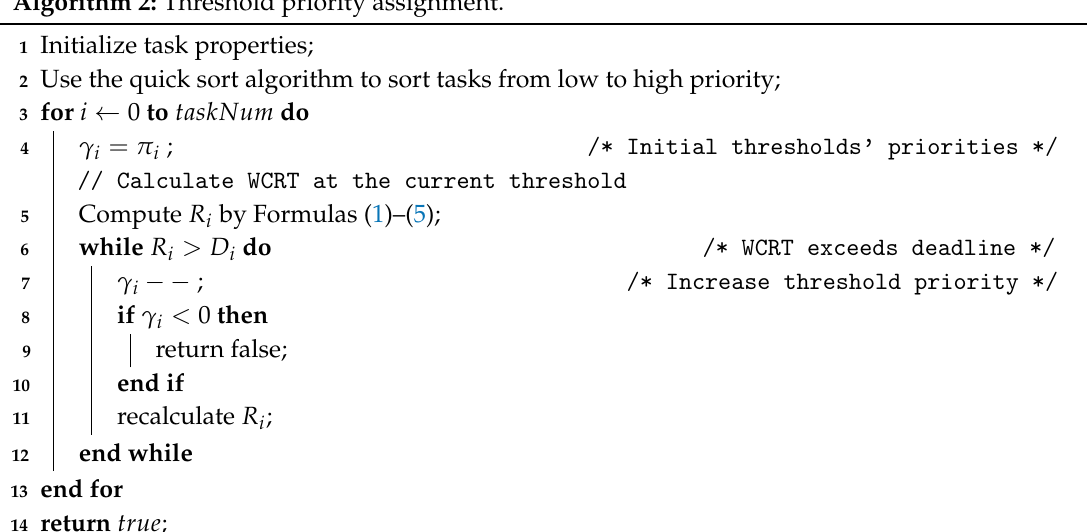
Algorithm 2: Threshold priority